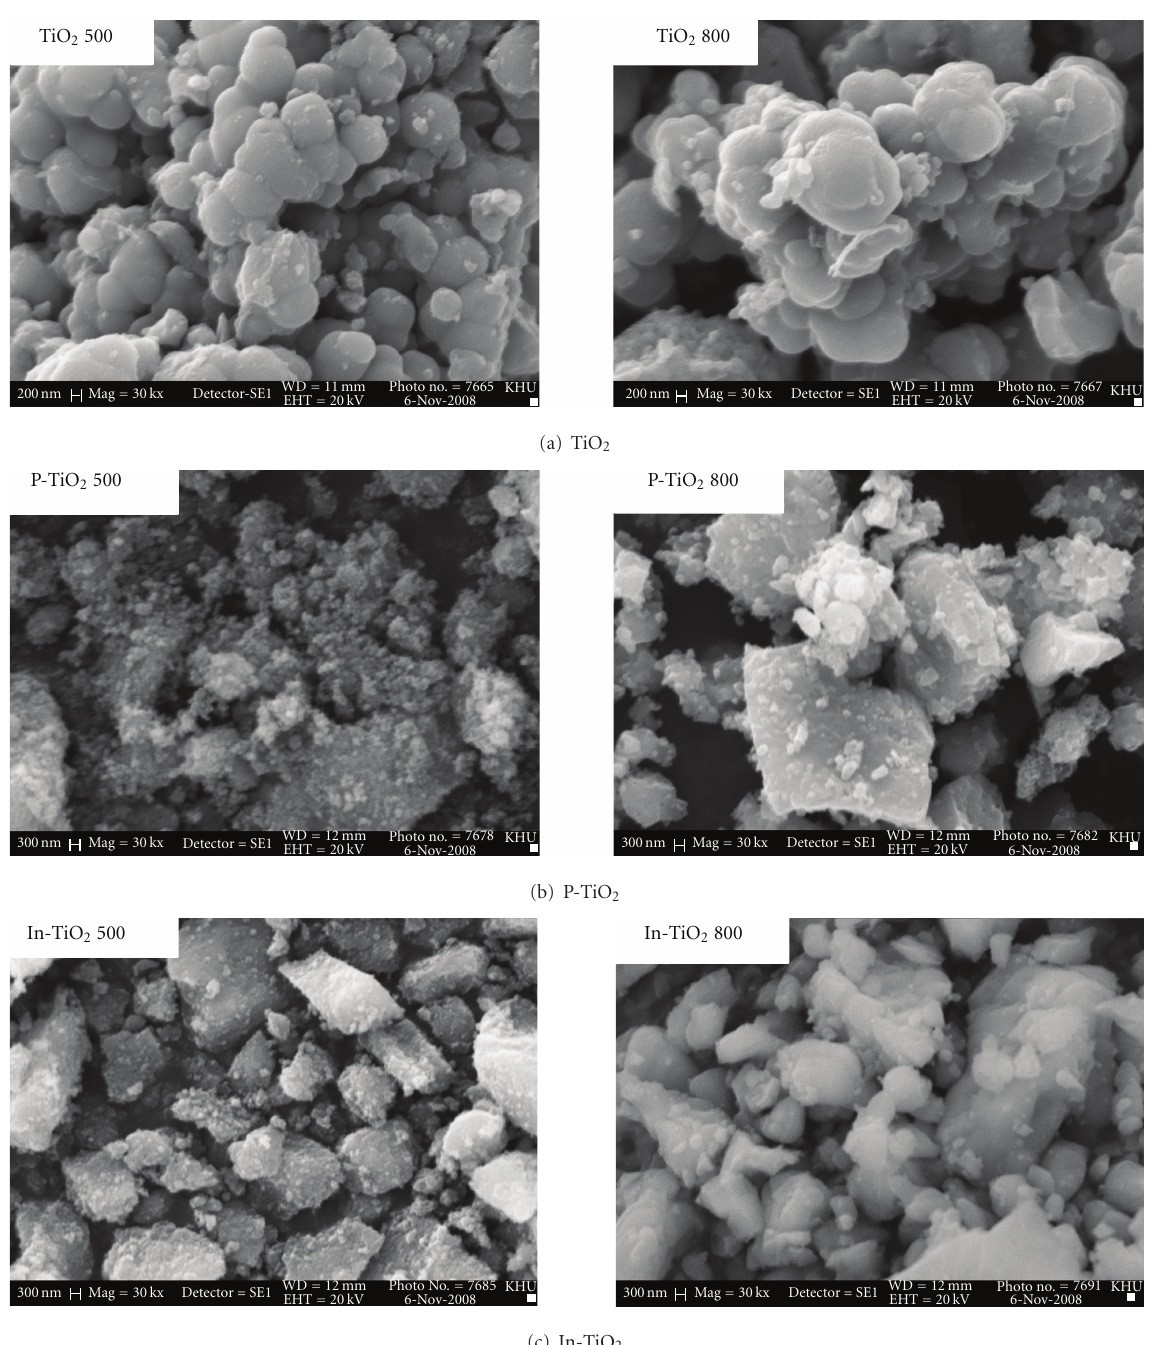
Figure 3: SEM micrographs of (a) TiO 2 (b) P-TiO 2 , and (c) In-TiO 2 photocatalysts treated at 500 ◦ C (anatase phase) and 800 ◦ C (rutile